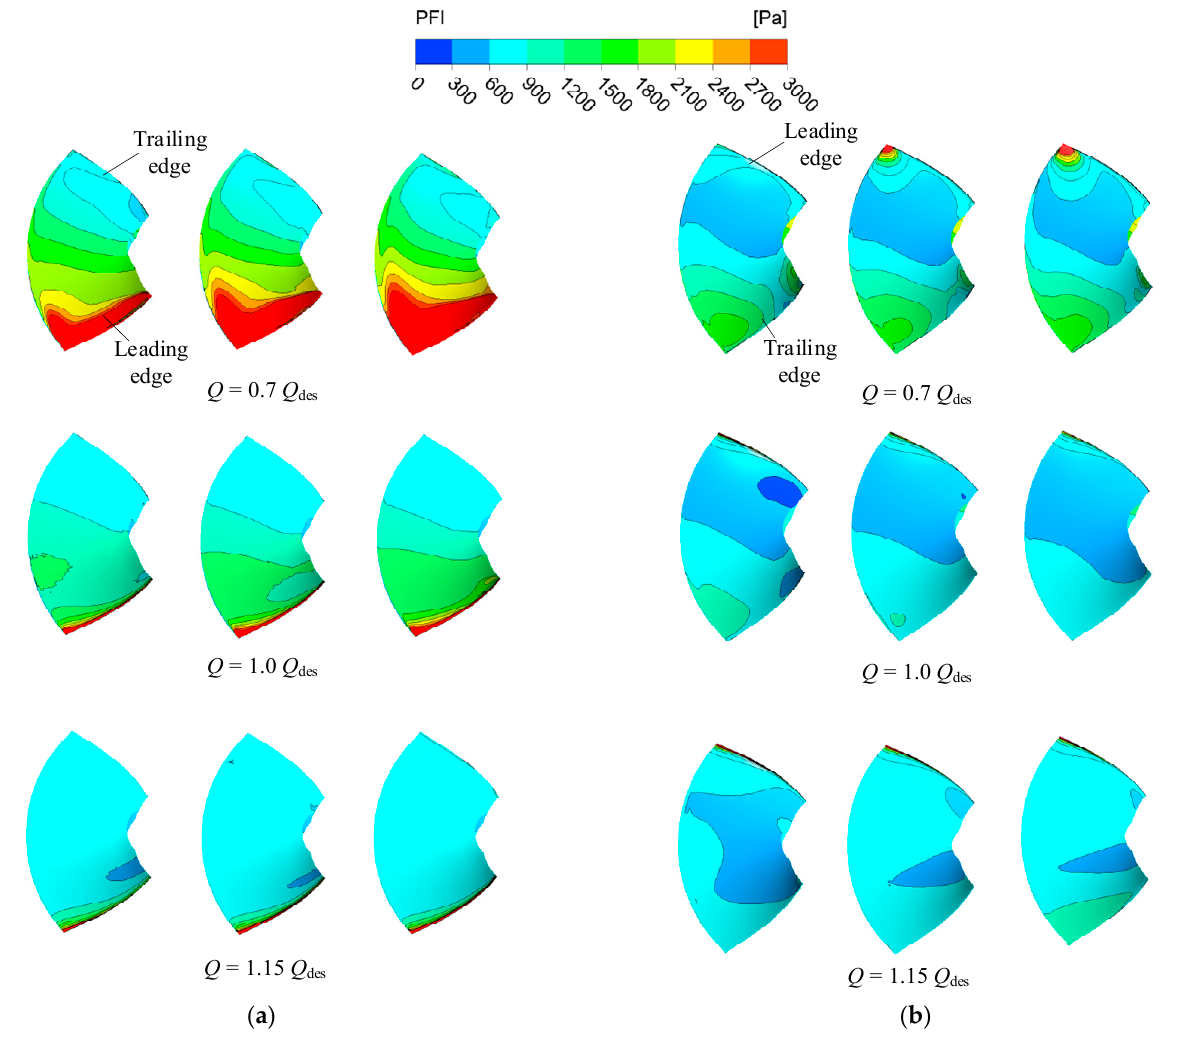
Figure 13. The distribution of PFI on ( a ) suction side and ( b ) pressure side of three kinds of blade under forward condition.